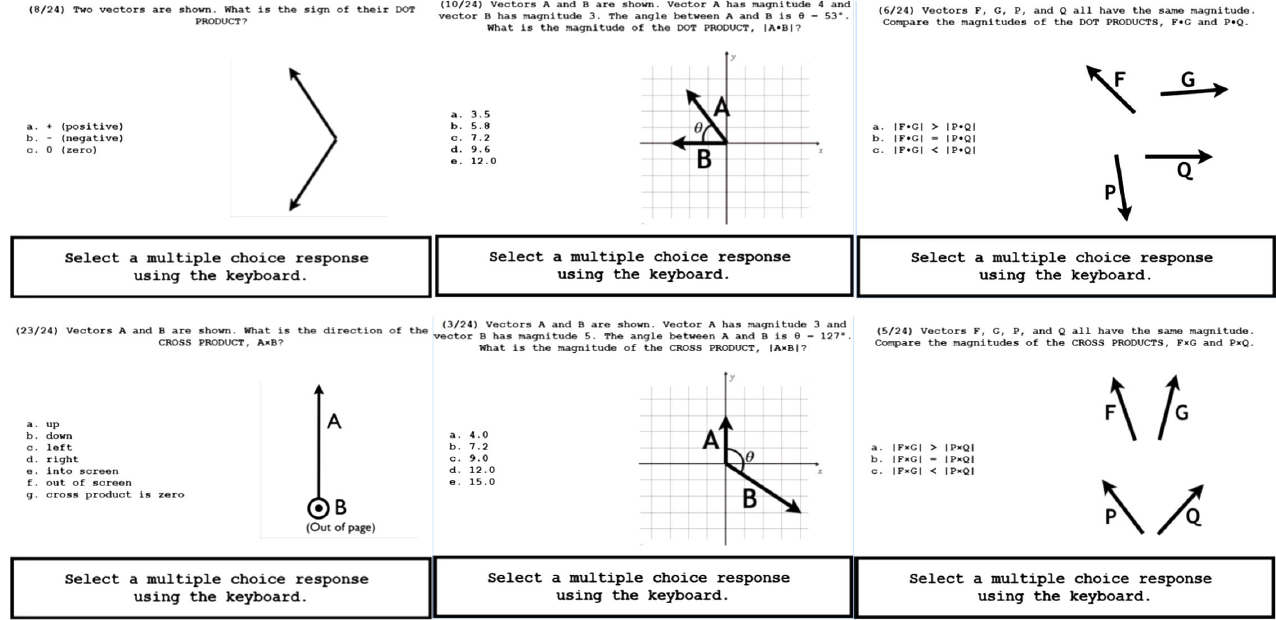
FIG. 1. Examples of each question type used during training. From left to right, top to bottom: Dot product determine sign, dot product determine magnitude, dot product compare magnitudes, cross product determine direction, cross product determine magnitude, and cross product compare magnitudes.